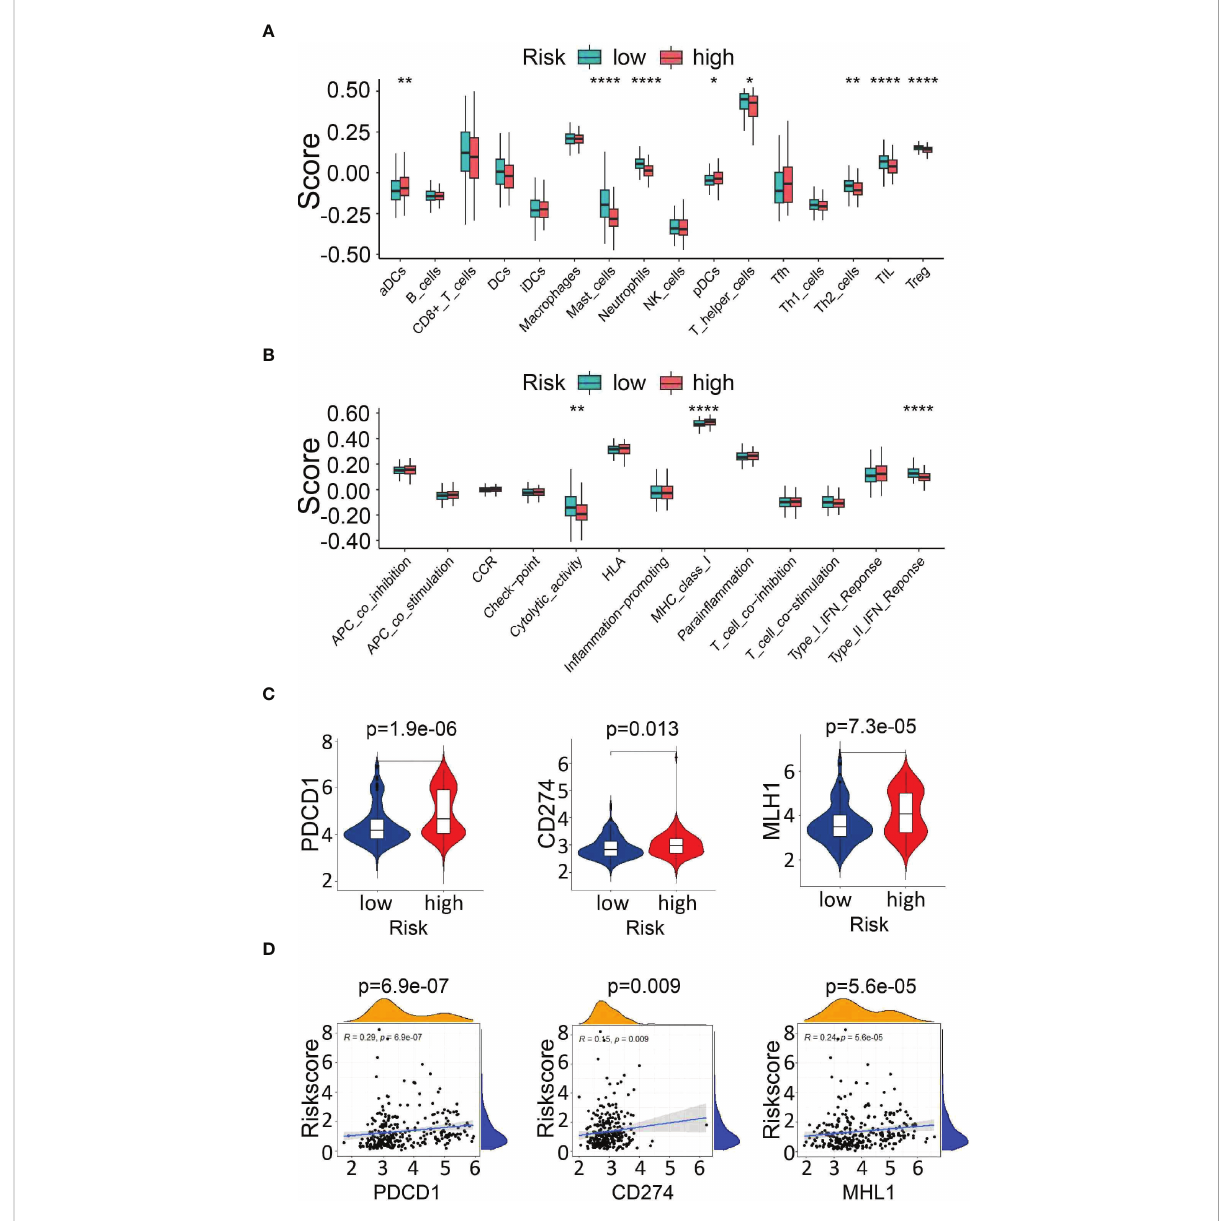
FIGURE 9 Analysis of immune cell in fi ltration and immune checkpoint genes. (A, B) Comparison of immune cells and immune-related pathways between the high- and low-risk groups. (C) Expression of immune checkpoint genes (PDCD1 and CD274) and the DNA mismatch repair gene MLH1 between the high- and low-risk groups. (D) The correlation between the risk score and the expression of PDCD1, CD274, and MLH1. *P<0.05, **P<0.01 and